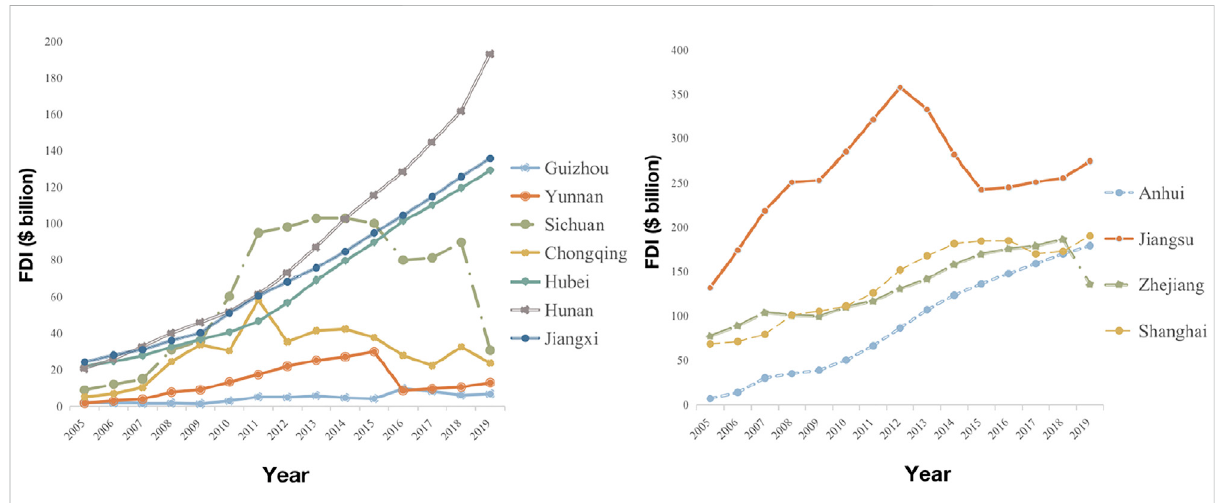
FIGURE 1 Scale of FDI in Yangtze River basin, 2005 –